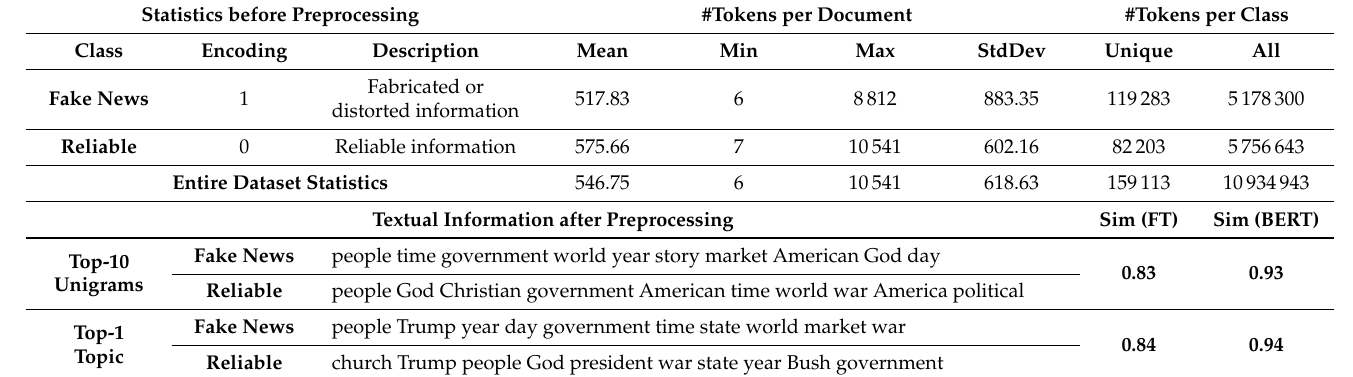
Table 1. Dataset description, statistics, and